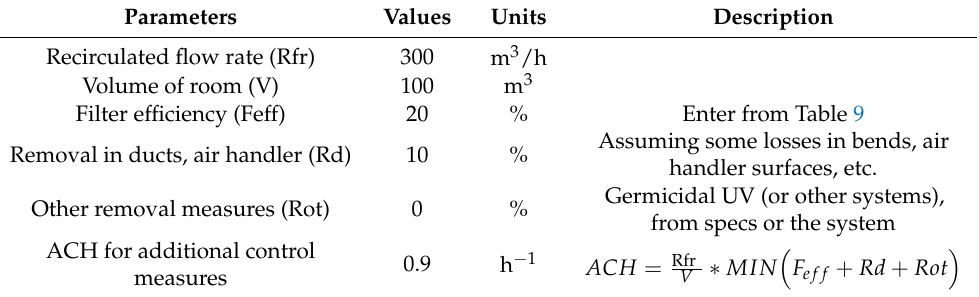
Table 8. Air Changes Per Hour (ACH) for additional control measures.